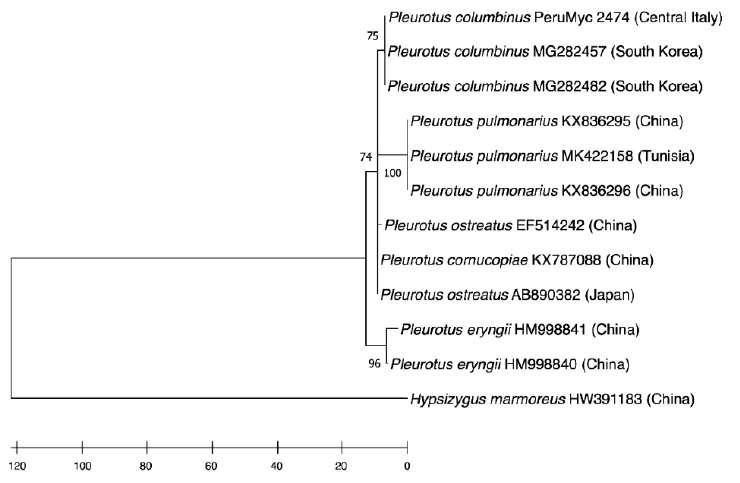
Figure 1. Maximum parsimony tree (obtained using the Min-mini heuristic algorithm) showing the phylogenetic position of the Pleurotus columbinus strain used in the present study (PeruMyc 2474). Sequences representing different Pleurotus spp. were used along with Hypsizygus marmoreus (seq. HW391183) as outgroup.